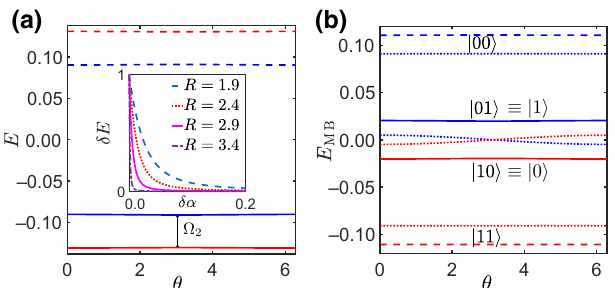
FIG. 2. (a) The single-particle energy spectrum E for the in- gap states as a function of θ for α 1 = 1.15, α 2 = 1.1 at R = 2.9. Here, (cid:7) 2 is the classical spin precession frequency that matches the qubit splitting. The inset shows the energy width δ E = (cid:11) (cid:12) (cid:11) (cid:12) ( 0 ) − (cid:4) (π) / (cid:4) ( 0 ) + (cid:4) (π) (cid:4) as a function of δα = α 1 − α 2 q q q q and for several values of R . (b) The many-body energy spec- trum E MB for α 1 = 1.15, α 2 = 1.1 and R = 2.9 in the absence of Coulomb interactions. The dotted lines represent the many- body energy spectrum for α 1 = α 2 = 1.1, showing a crossing at θ = π . Here, {| 10 (cid:4) , | 01 (cid:4)} and {| 00 (cid:4) , | 11 (cid:4)} label the odd- and even- parity states, respectively, with the YSR qubit being encoded in the former. In both plots, we use k F =